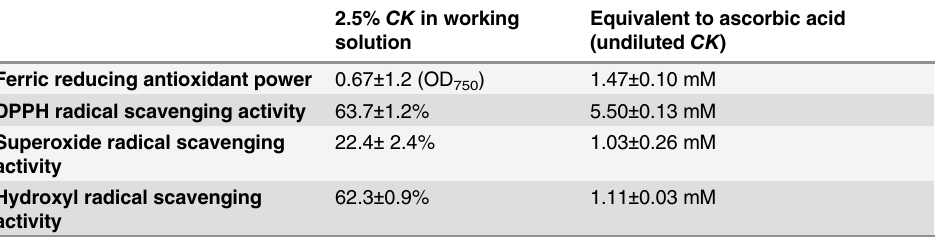
Table 1. Antioxidant Activities of CK